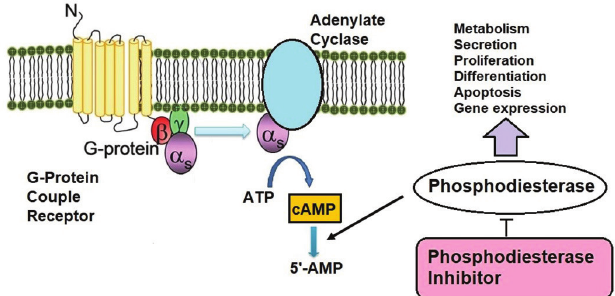
FIGURE 2 - G-Protein coupled receptor binding to ligand activates adenylate cyclase which form cAMP by ATP. Reaction is catalyzed by phosphodiesterase. Inhibition of phosphodiesterase leads to various physiological functions. ATP, adenosine triphosphate; cAMP, cyclic adenosine monophosphate; 5’AMP, 5’ Adenosine